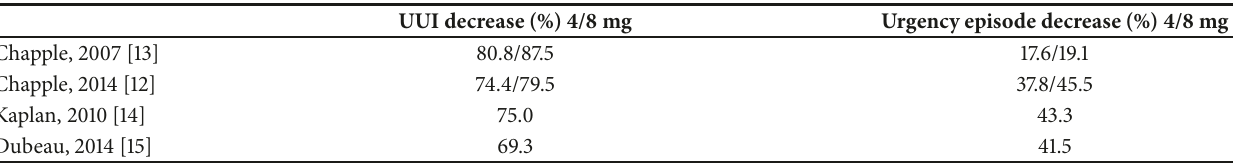
Table 1: Percentage decrease in urinary urgency incontinence and urgency episodes according to different studies with fesoterodine at 4 and 8